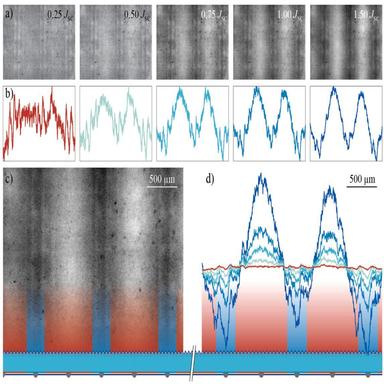
a) EL images of the Zebra IBC SC (from the front) at five different injection levels, and b) their respective extracted and normalised EL profiles. c) Closeup EL image at 1.5 JSC injection level, and d) Comparison of the mean subtracted and normalised EL profiles at different injection levels.